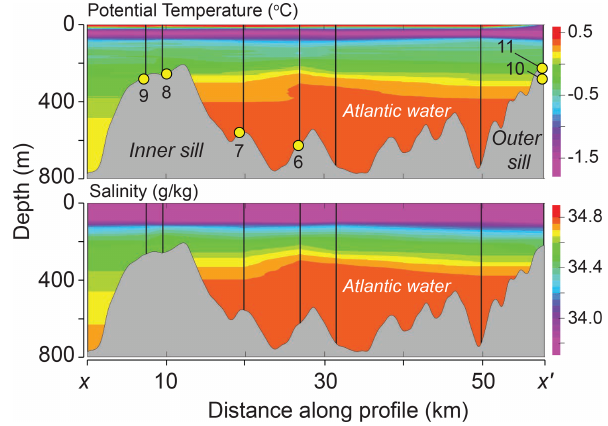
Figure 3. Potential temperature and salinity profiles illustrating the distribution of Atlantic water in Sherard Osborn Fjord. Vertical black lines are positions of CTD (conductivity, temperature, and depth) casts conducted during Ryder 2019. Yellow circles are the locations of coring sites. The position of site 10 on the outer sill is projected, as this profile does not cross its location (see Fig. S1 in the Supplement for the details on the location of the oceanographic